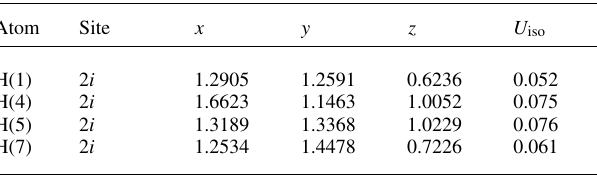
Table 2. Atomic coordinates and displacement parameters (in Å 2 )